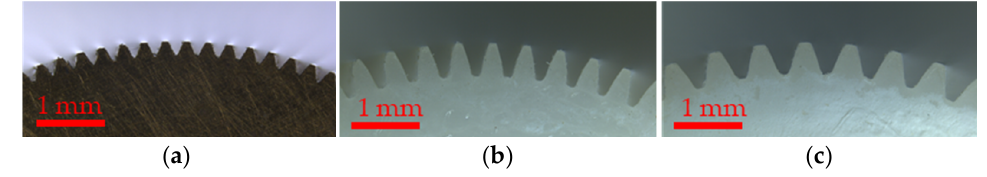
Figure 2. Types of gears used in the corrugating process: ( a ) module 0.1, ( b ) module 0.15, and ( c ) module 0.2.